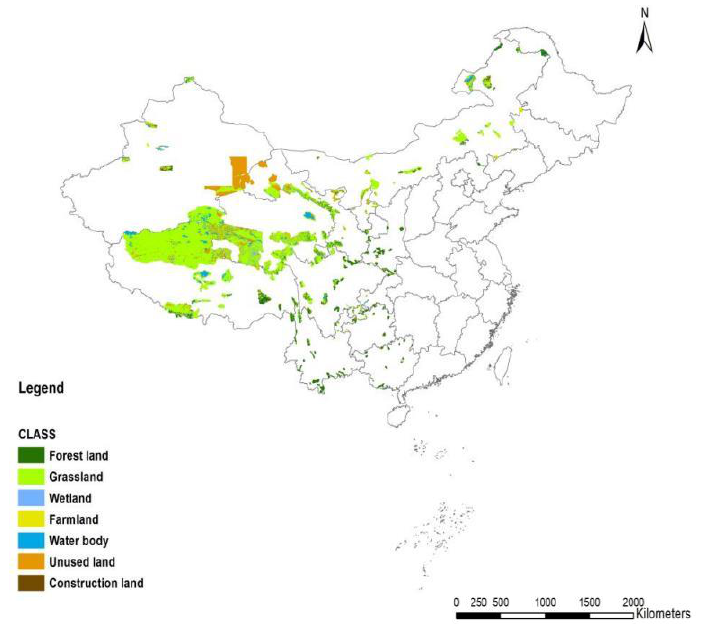
Figure 3. Land use in the national nature reserves of western China in 2005.